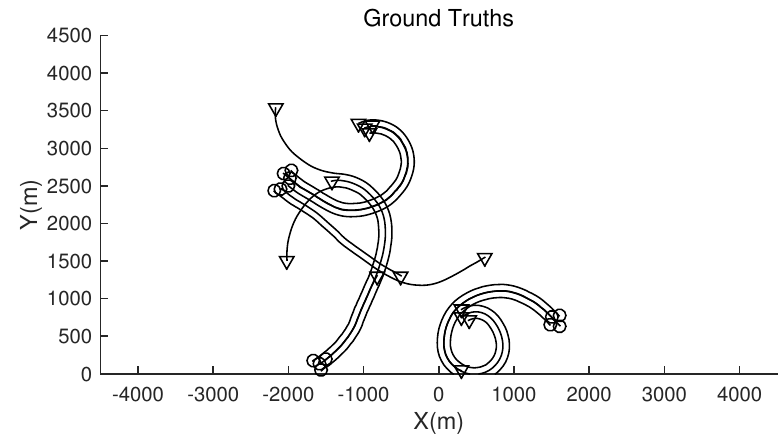
Figure 8. The structure of subgroup targets during k >